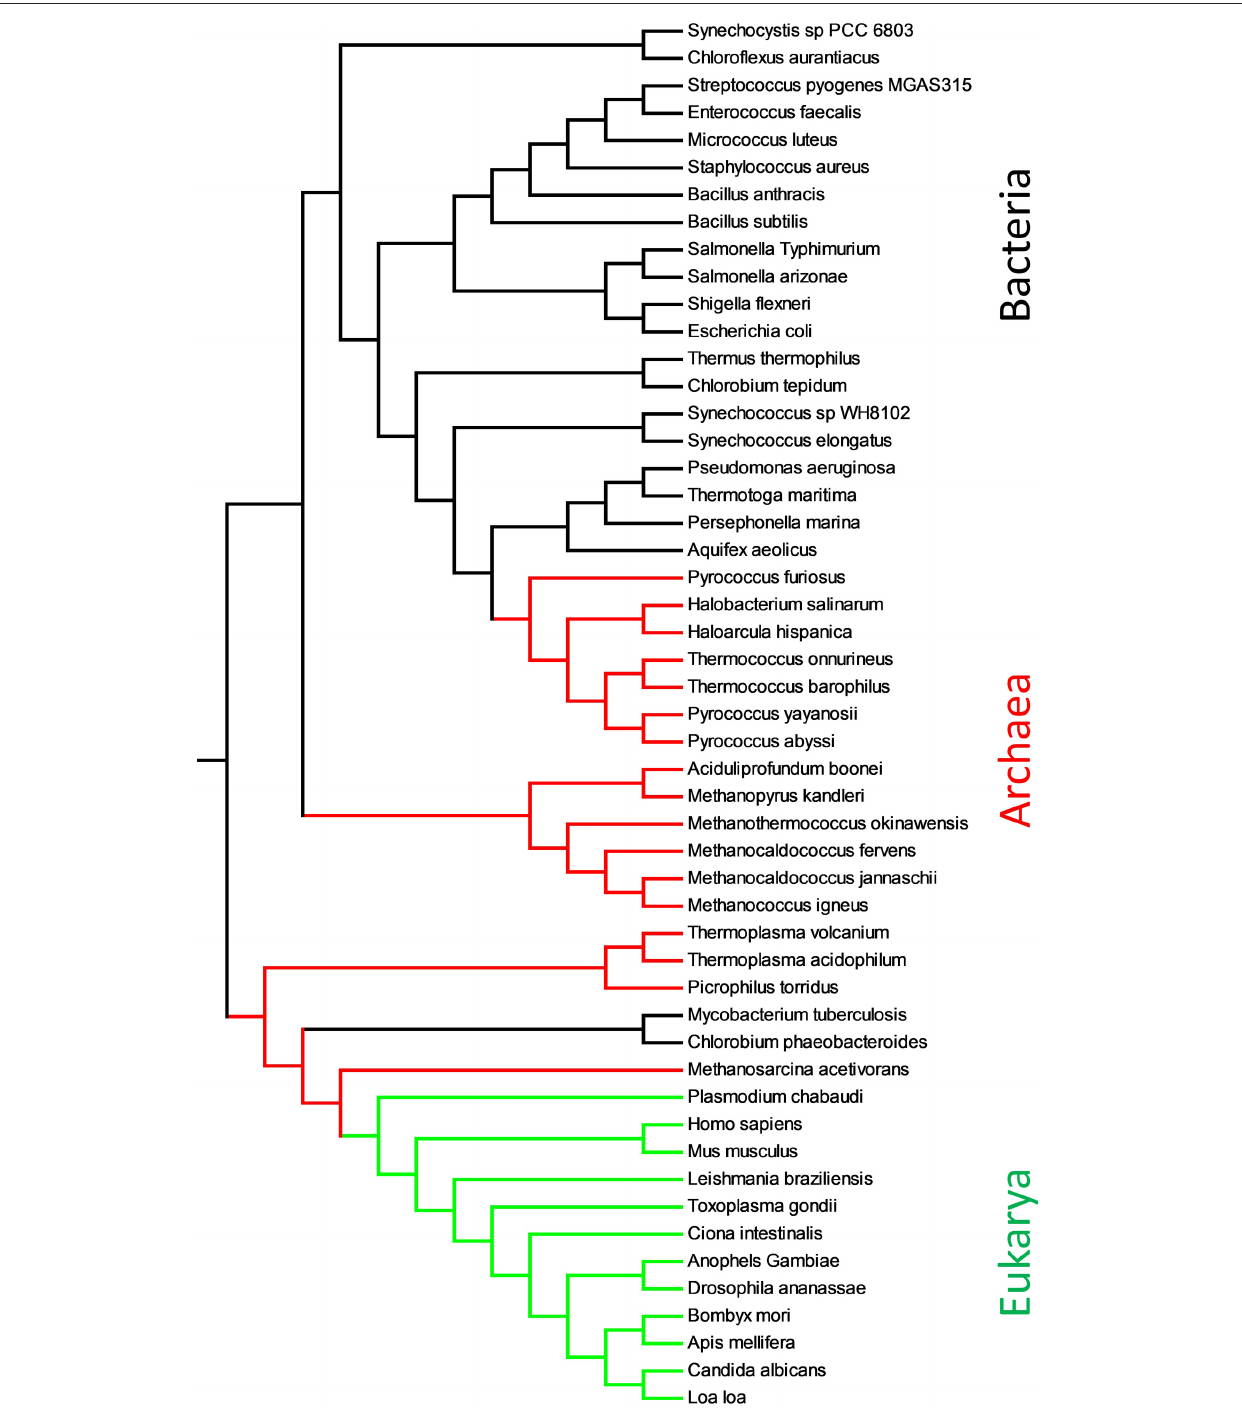
potential antimicrobial sequences. For example, S. flexneri could be regarded as a sort of reservoir of